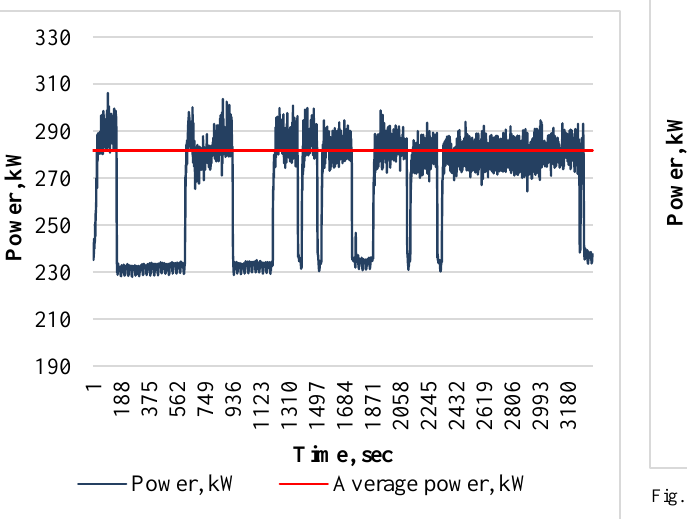
Fig. 5. Electric power in pre-milling mode for modified operation scheme.